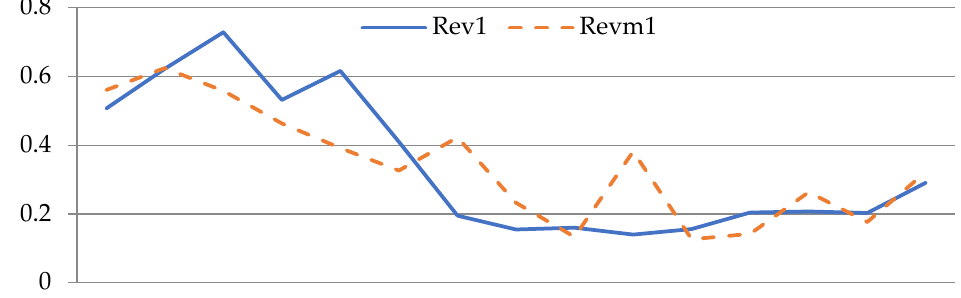
Figure 2. Comparison between real revenue and model value calculated by Formula (1) for industry No. 2 (author’s results). Figure 3. Comparison between real revenue and model value calculated by Formula (1) for industry No. 3 (author’s results). Figure 4. Comparison between real revenue and model value calculated by Formula (1) for industry No. 4 (author’s results).